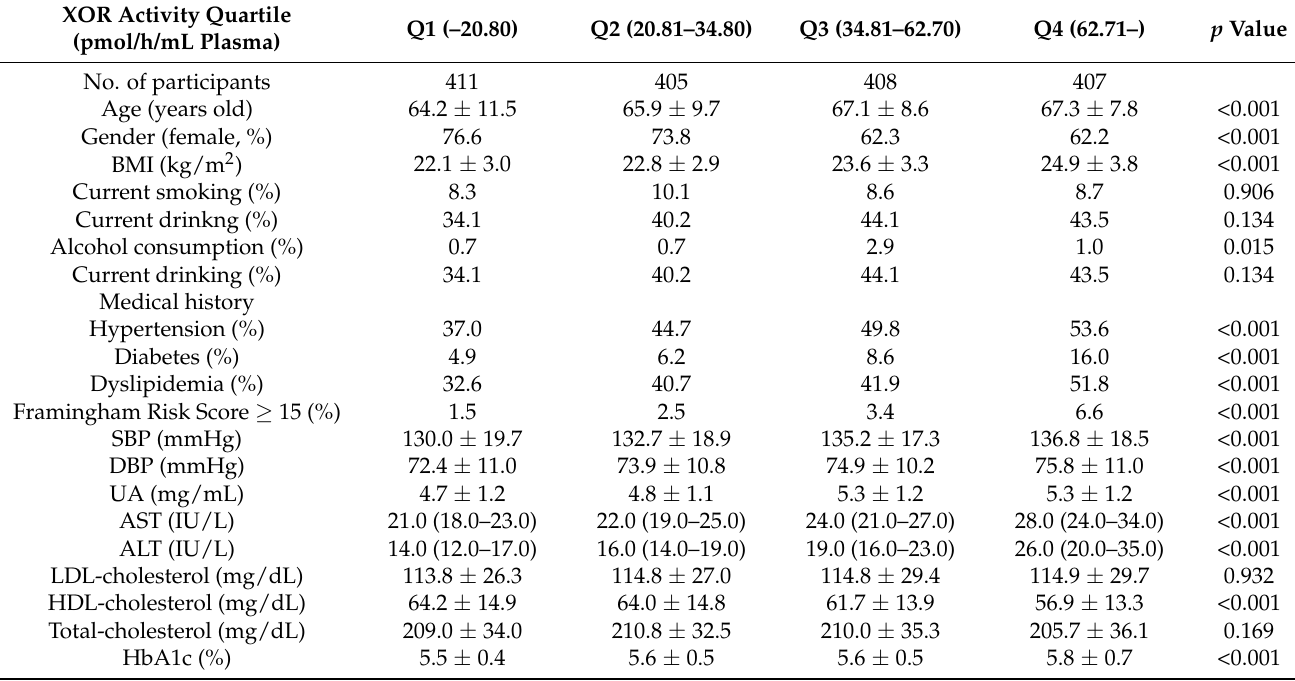
Table 5. The baseline characteristics were classified into quartiles of XOR